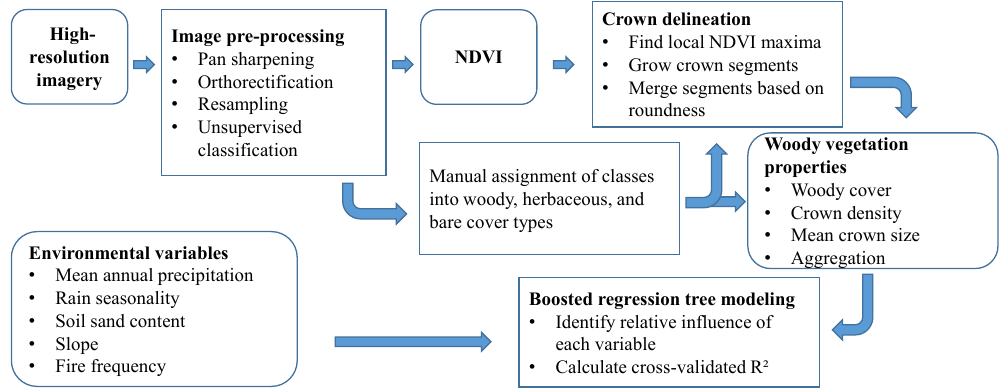
Figure 1. Methodological workflow showing datasets (rounded boxes) and methods (square boxes) used to estimate woody vegetation structure and analyze relationships with environmental variables.